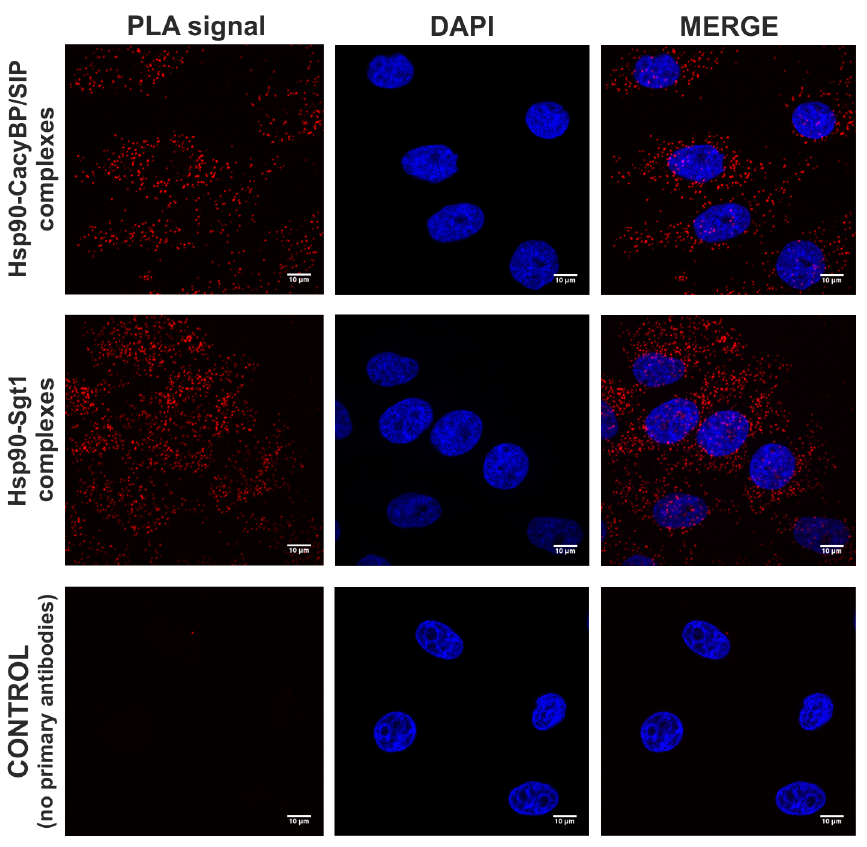
Fig 3. Presence of Hsp90-CacyBP/SIP and Hsp90-Sgt1 complexes in HEp-2 cells analyzed by PLA assay. Complexes of examined proteins are visualized in red; cell nuclei, stained with DAPI, are in blue. Scale bar is 10 μ